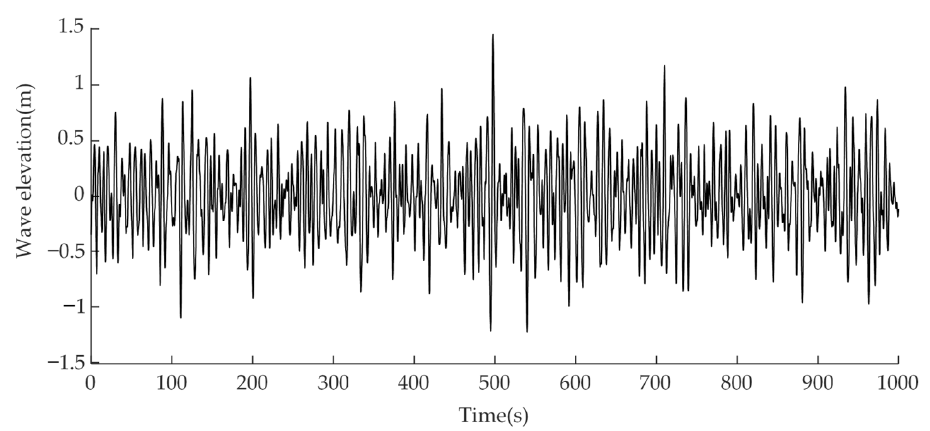
Figure 12. The time history of the wave elevation.